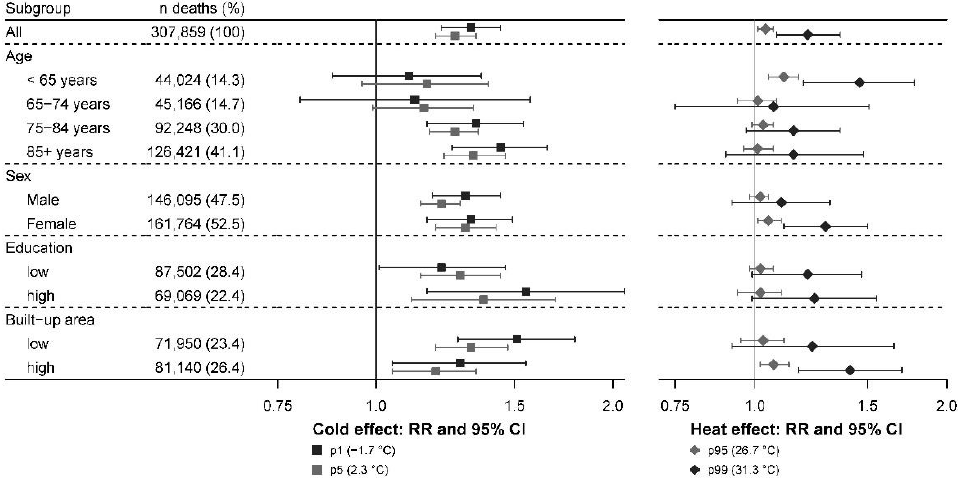
Figure 4. Cold effect (1st and 5th percentiles of temperature versus minimum-mortality temperature) and heat effect (95th and 99th percentiles of temperature versus minimum-mortality temperature) of temperature on mortality cumulated over lags of 0–21 days by subgroup, 2010–2015.